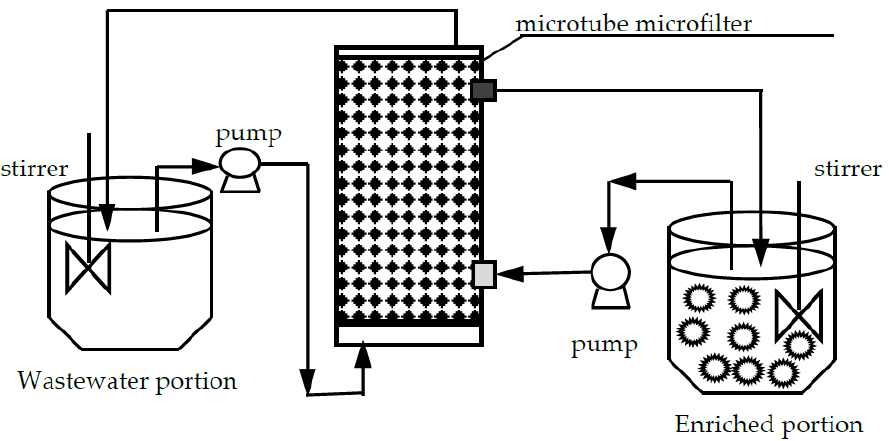
Figure 1. Installation of microtube microfilter reactor with organic phosphoric system procedure.